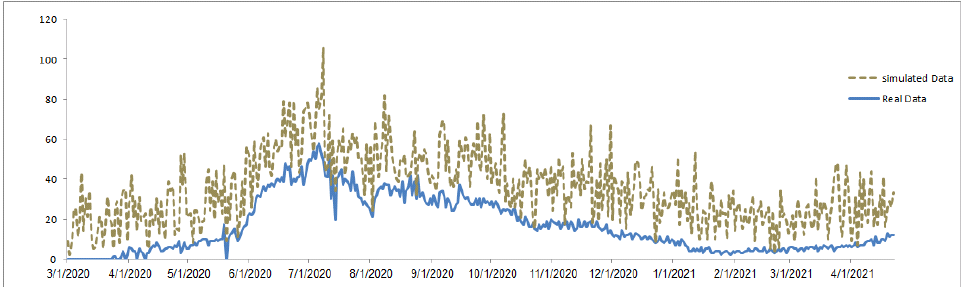
Figure 16. Comparison between real and simulated data for deaths class in the considered